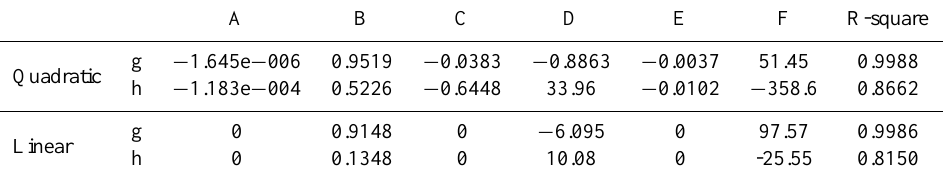
Table 2. The coefficients of Eqs. (5) and